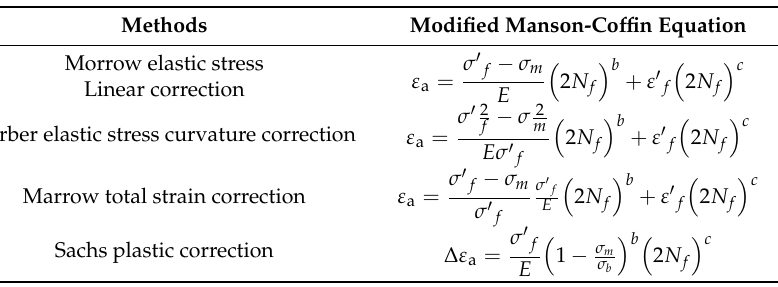
Table 7. Modified Manson-Coffin equation when R e (cid:54) = − 1.